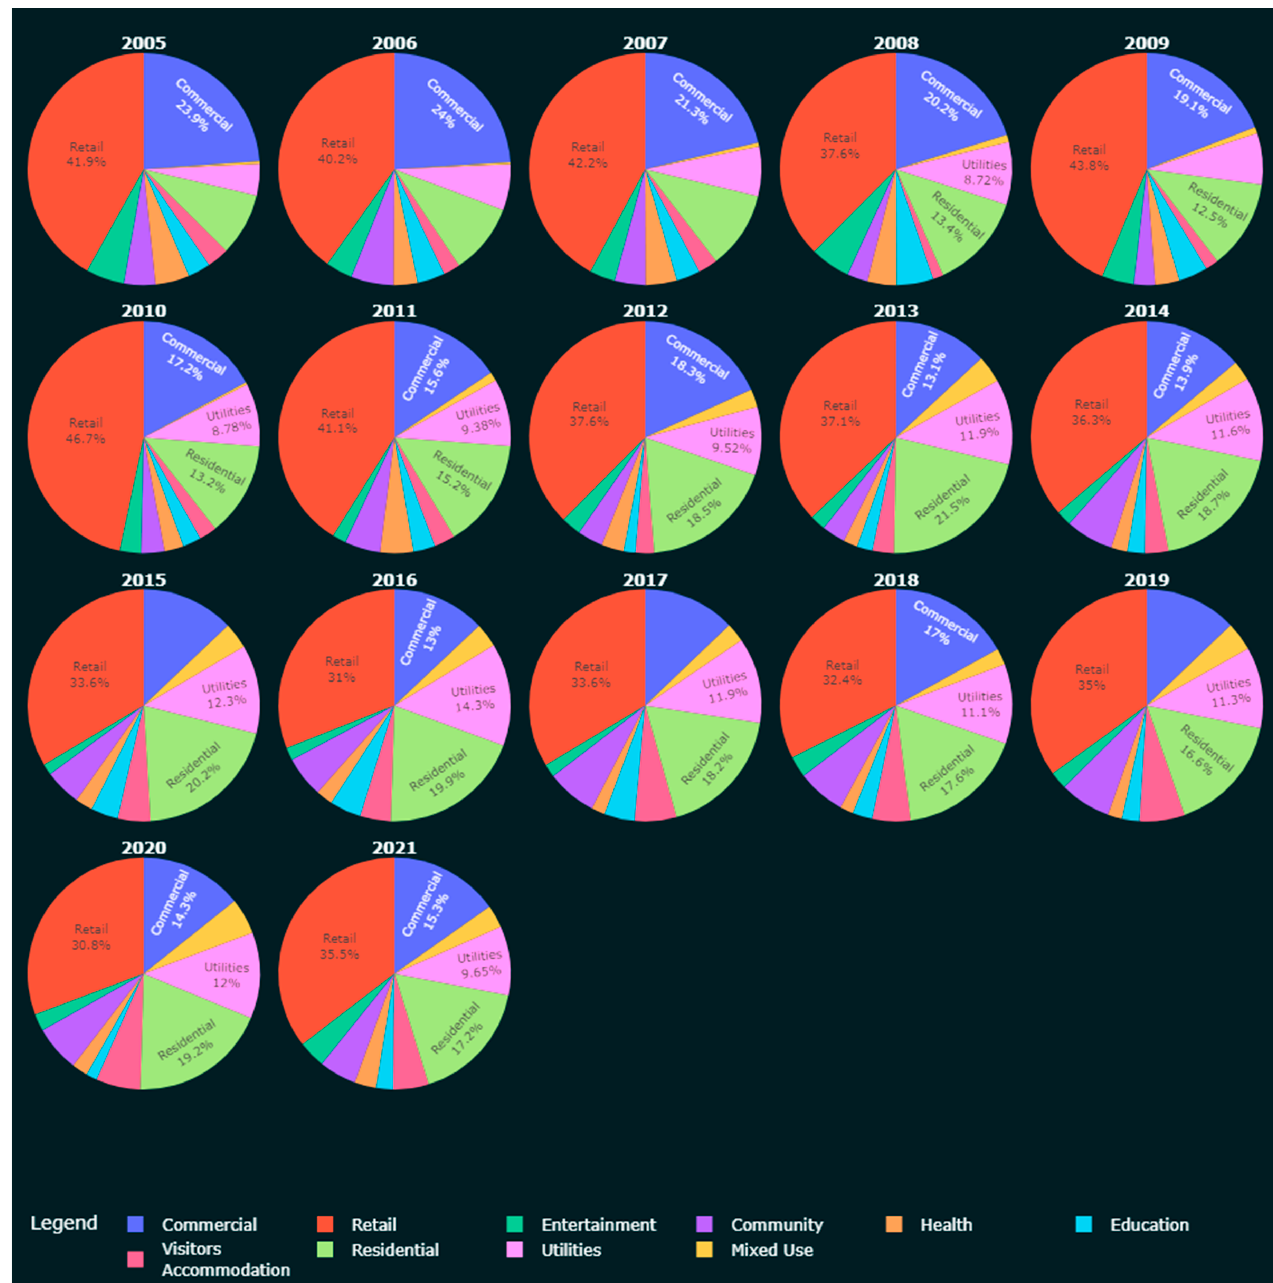
Figure 32. Number of DAs by proposed uses by year (2005–2021).